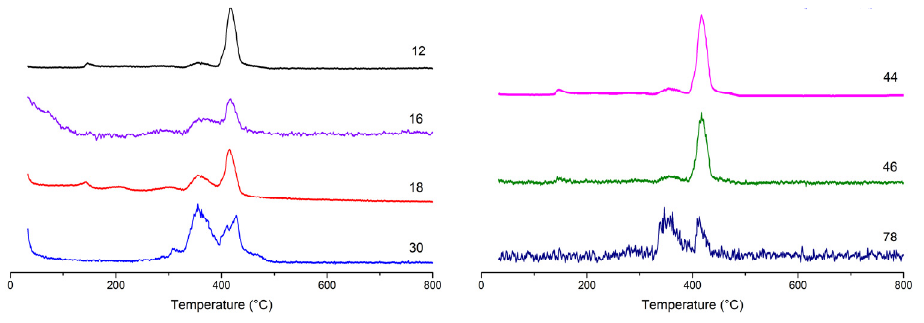
Figure 11. Mass spectra of copper nanocomposite 2 .